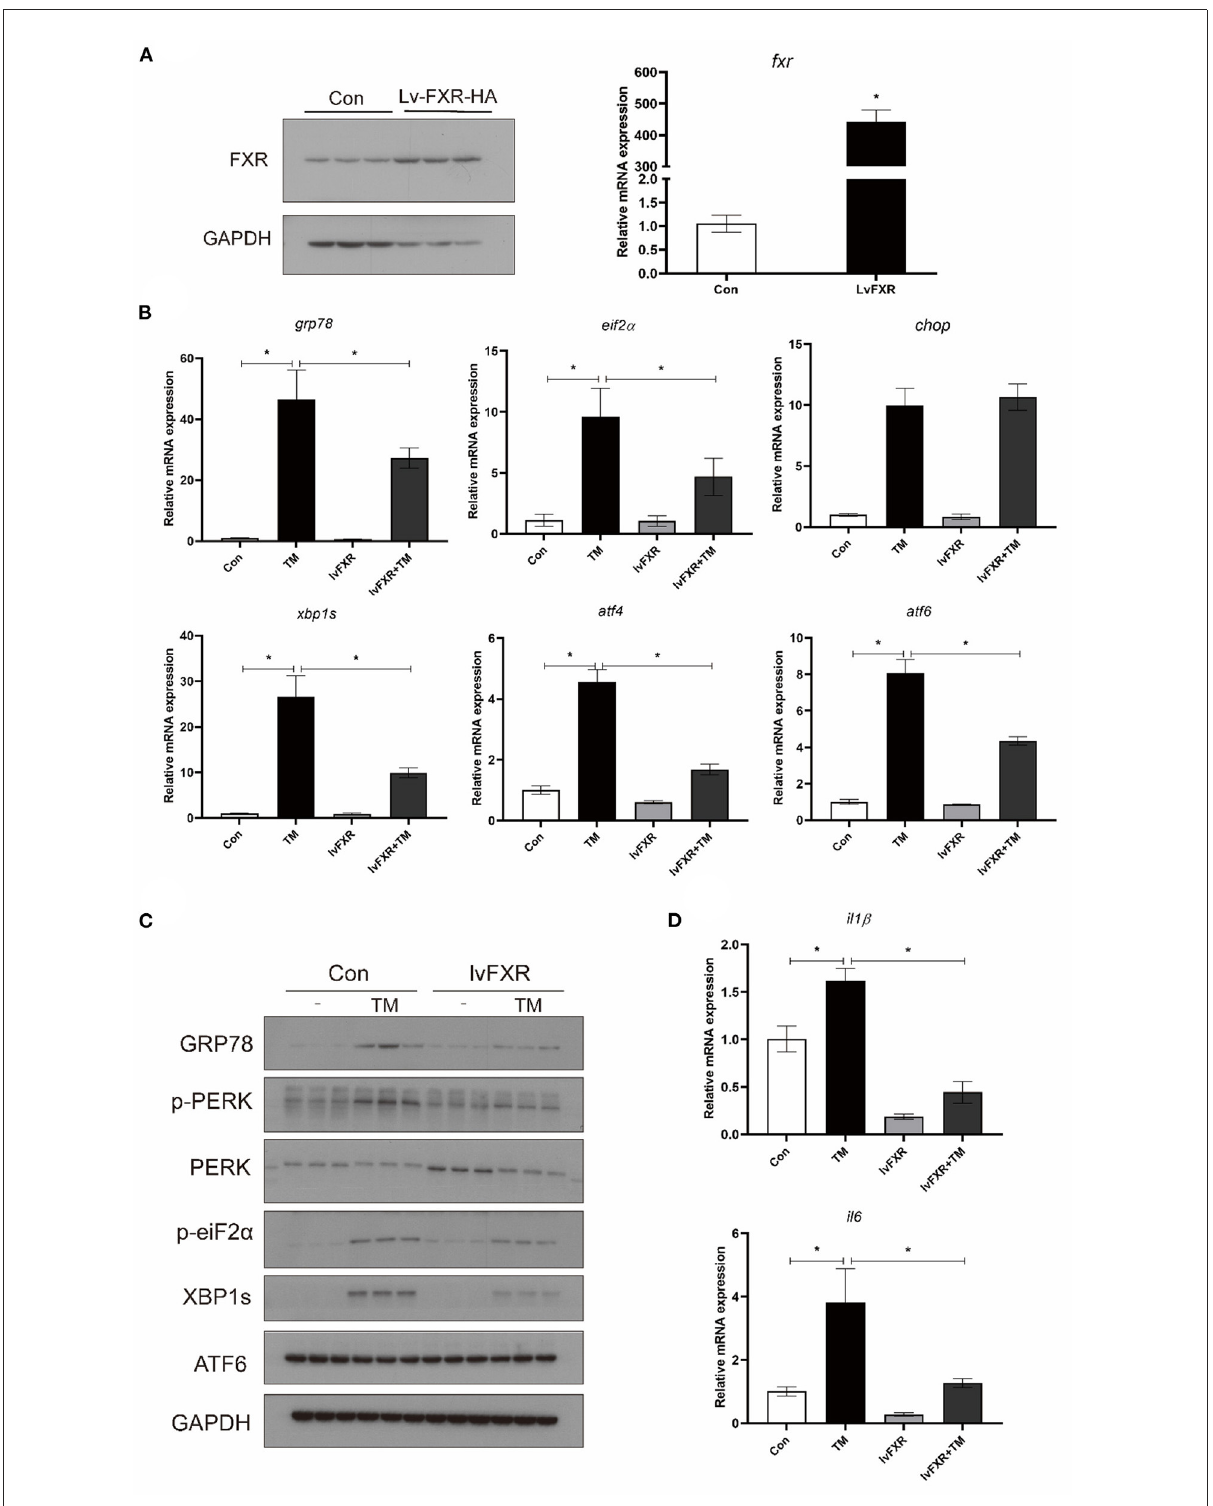
FIGURE5 Effects of (A) FXR overexpression on TM-induced ER stress and inflammation in croaker macrophages. (B) Gene expression and (C) protein level of ER-stress markers in stably FXR-transfected macrophages after TM treatment. (D) Expression of IL1 β and IL6 in stably FXR-transfected macrophages after TM treatment. *Different between two groups; P < 0.05 (means ± SEMs; n = 3; Student’s t